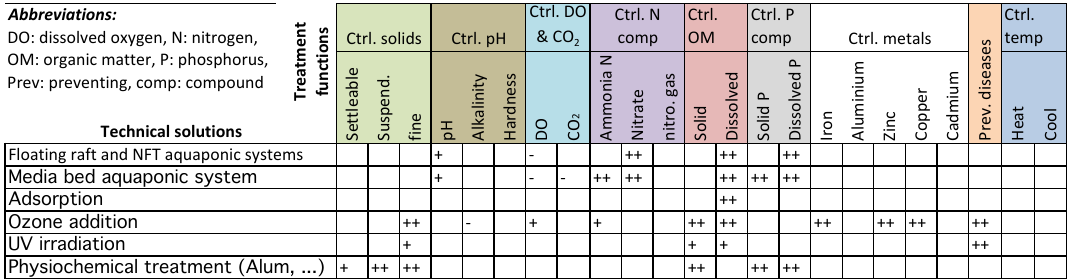
Table 7. QFD matrix presenting how aquaponic systems, adsorption, ozonation, UV irradiation and physicochemical treatment influence different treatment functions.